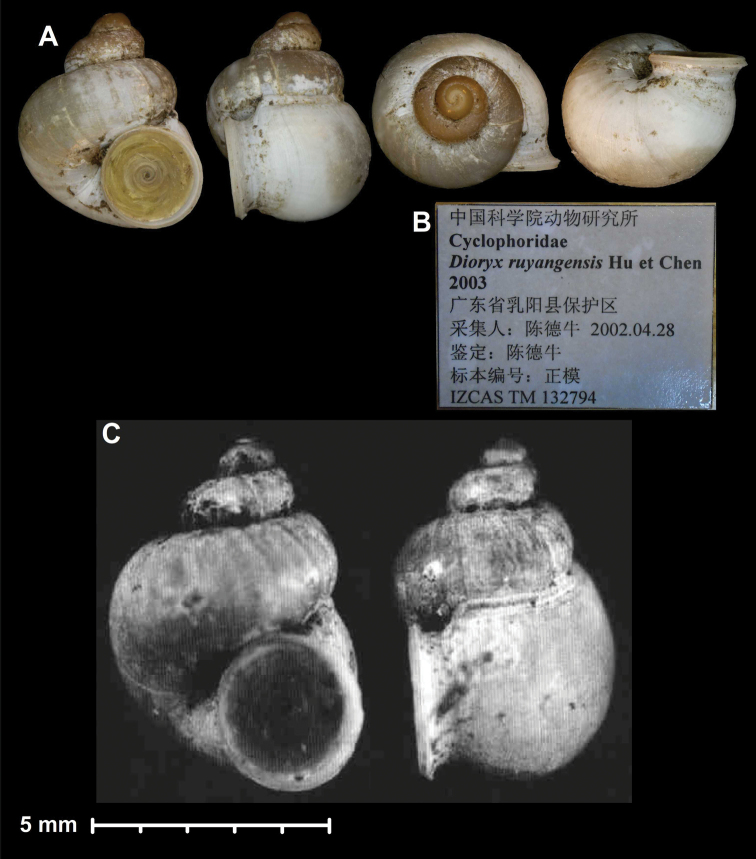
Shells of Dioryx Benson, 1859 species ADioryx
ruyangensis Hu, Yin, & Chen, 2004, holotype (IZCAS TM 132794) B label of the holotype C figures from the original description of Dioryx
ruyangensis Hu, Yin, & Chen, 2004. Photographs: Kaibaryer Meng (A, B).